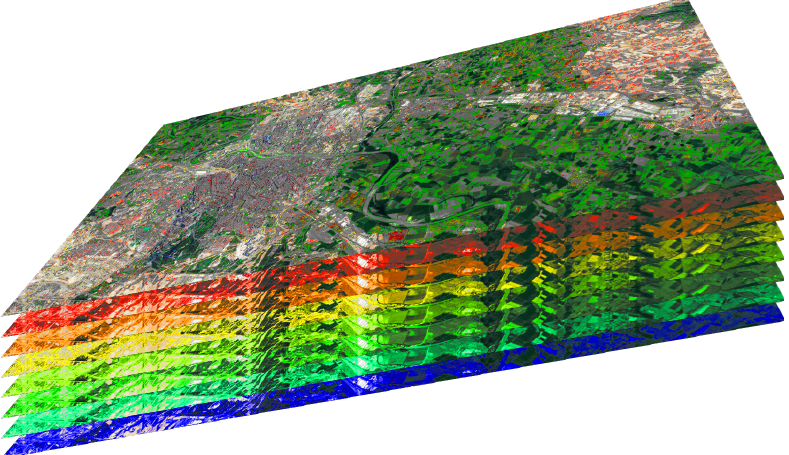
Figure 10. Hyperspectral image example.